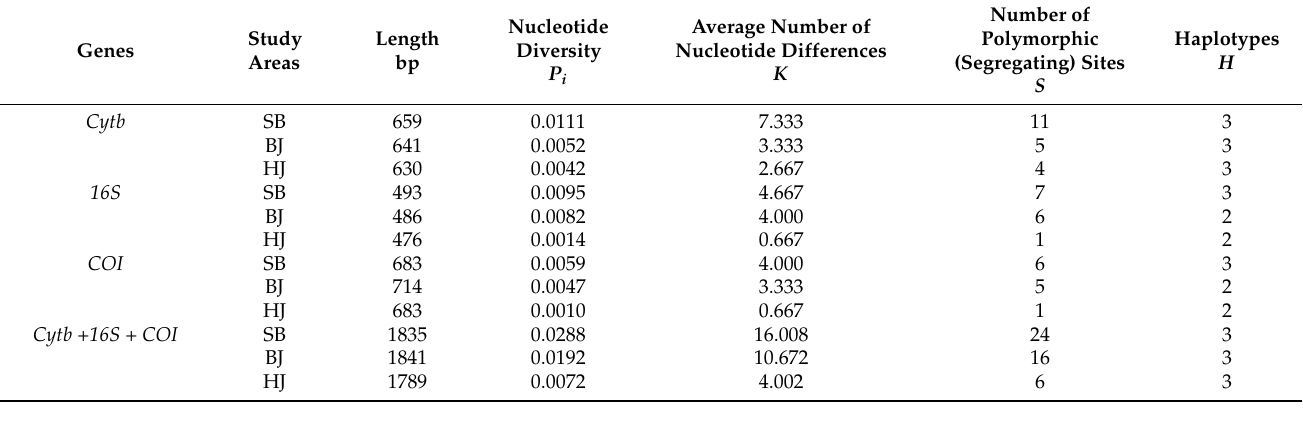
Table 2. Nucleotide polymorphism parameters of Erythroneurine leafhoppers population in different study areas.